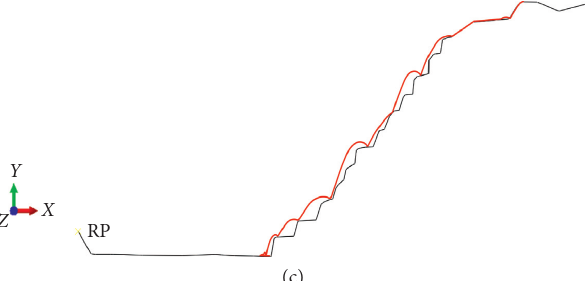
Figure 6: Rock-dropping simulation to which the developed model applied: (a) section 1; (b) section 2; (c) section 3.